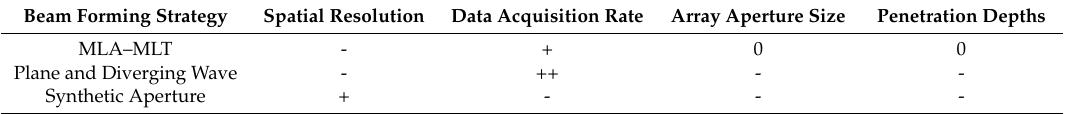
Table 1. This table summarizes the peculiarities of each modality. A plus or minus sign means that the performance with respect to that specific imaging feature (one for each column) is improved or reduced, respectively. The 0 sign means that there is no significant variation. The evaluation is performed with respect to standard beam-forming performance.